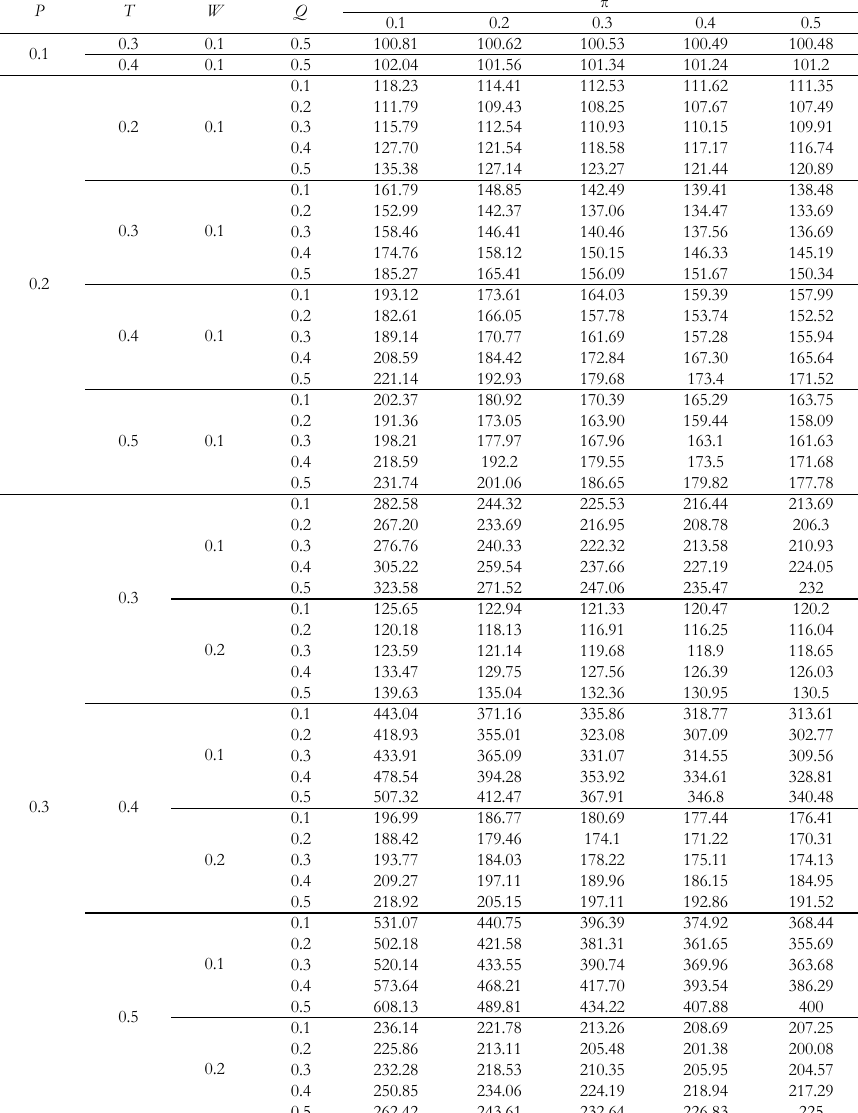
Percent RE of the proposed model over the OS